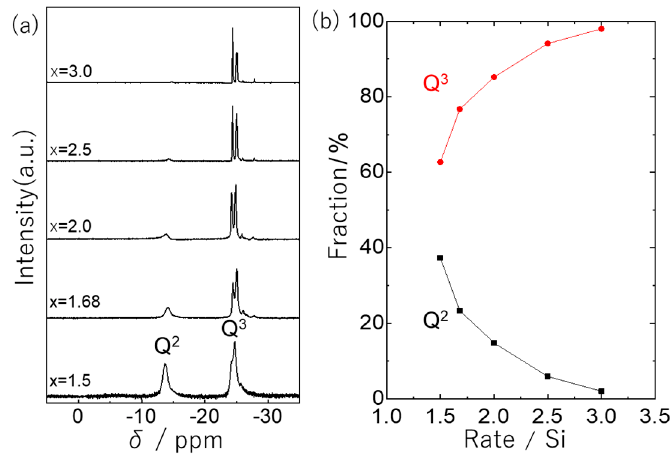
Figure 4. ( a ) The 31 P NMR spectra and ( b ) the corresponding fraction of Q 2 and Q 3 units at each composition calculated from 31 P NMR spectra in the H 3 PO 4 -(C 6 H 4 )(Me 2 SiCl) 2 system.